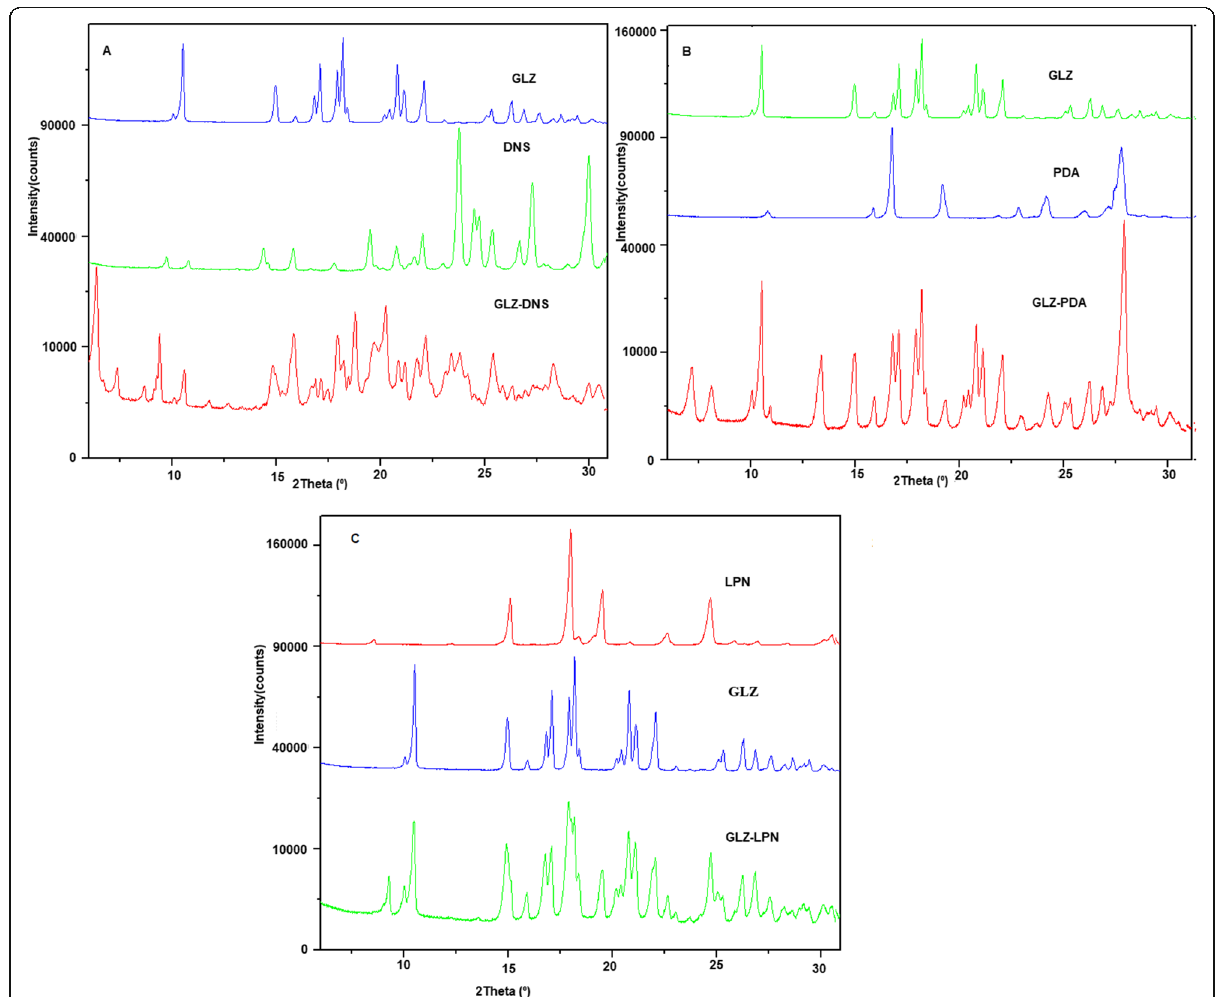
Fig. 3 PXRD patterns of A GLZ – DNS, B GLZ – PDA, and C GLZ – LPN